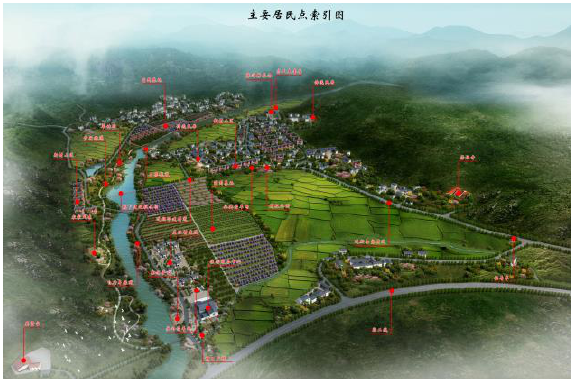
Figure 8. Bird view of the rejected proposal. Source: courtesy of the local government.